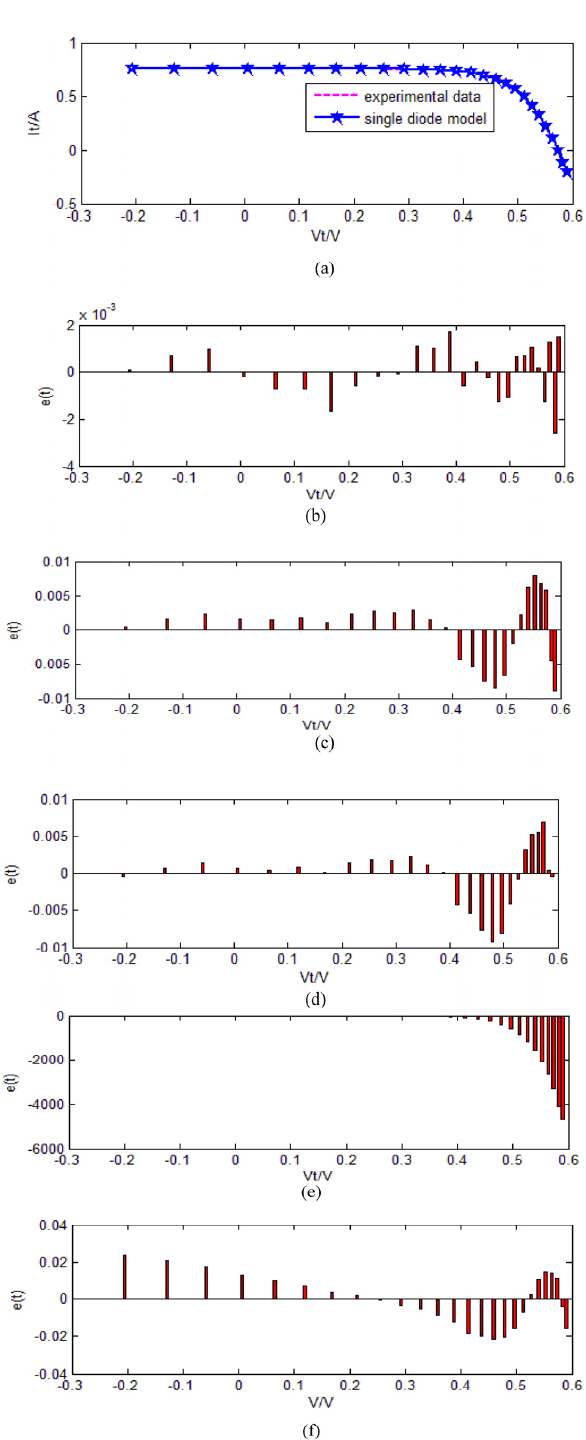
Figure 7. The comparison of the results of four methods for the double diode model: ( a ) comparison between the I - V characteristics generated using our proposed method and the measured data; ( b ) relative error for each measured value based on the identified parameters using IABC algorithm; ( c ) relative error for each measured value based on the identified parameters using ABC algorithm; ( d ) relative error for each measured value based on the identified parameters using DE algorithm; ( e ) relative error for each measured value based on the identified parameters using PSO algorithm; ( f ) relative error for each measured value based on the identified parameters using ABSO